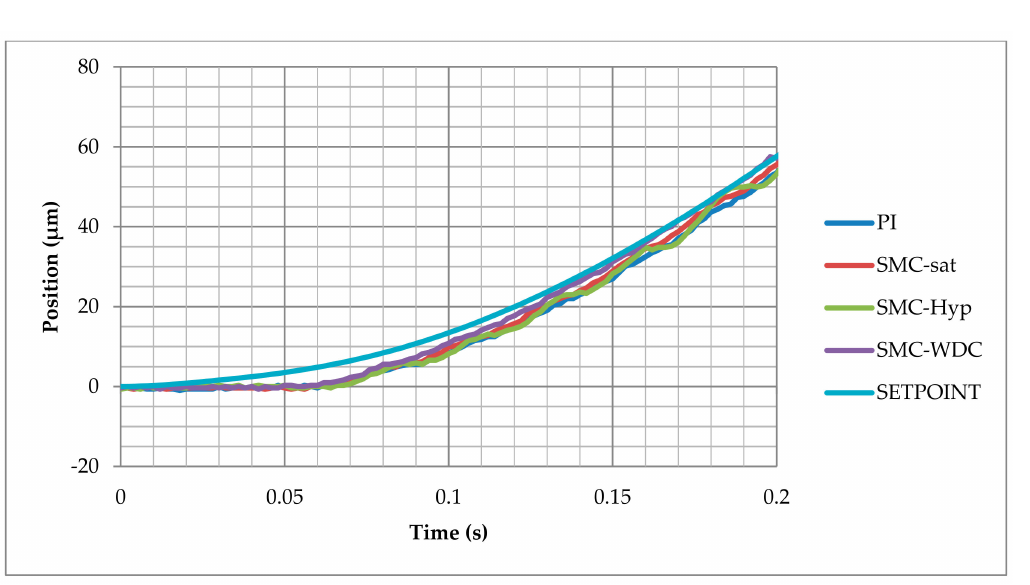
Figure 10. Response delay comparison between the di ff erent control strategies in the sinusoidal